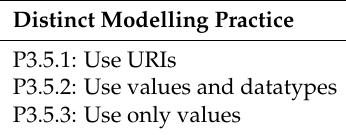
Table 36. Distinct modelling practices of data portals regarding the values of the temporal